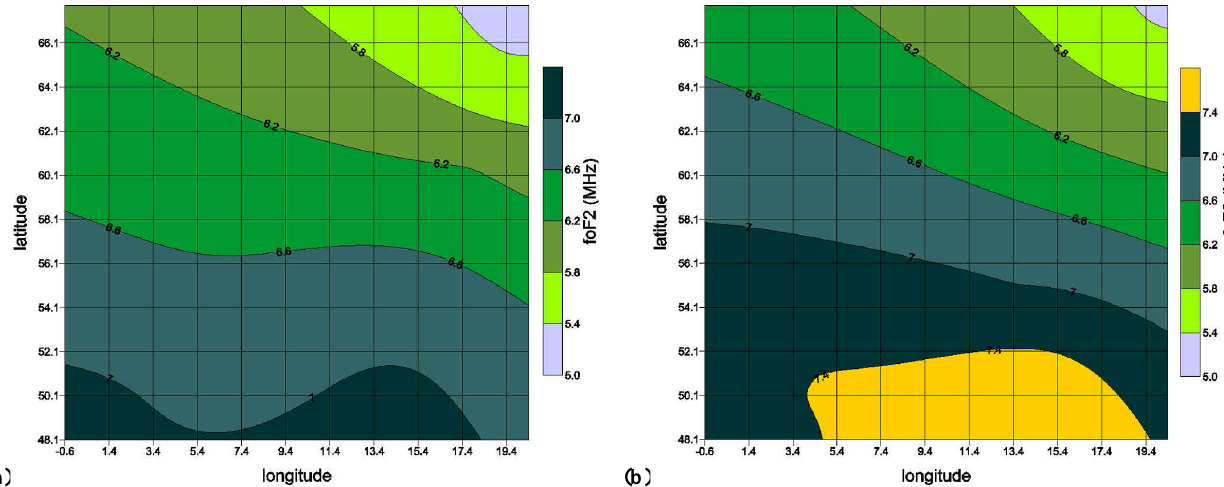
Fig. 4. (a) Map obtained from fo F2 measurements and (b) forecasting map for fo F2 three hour in advance generated using the IFERM model on 2 May 1991 at 15:00UT under very disturbed geomagnetic conditions (ap( τ = 0.8) = 45.3; ap( τ = 0 . 9 ) = 33 .